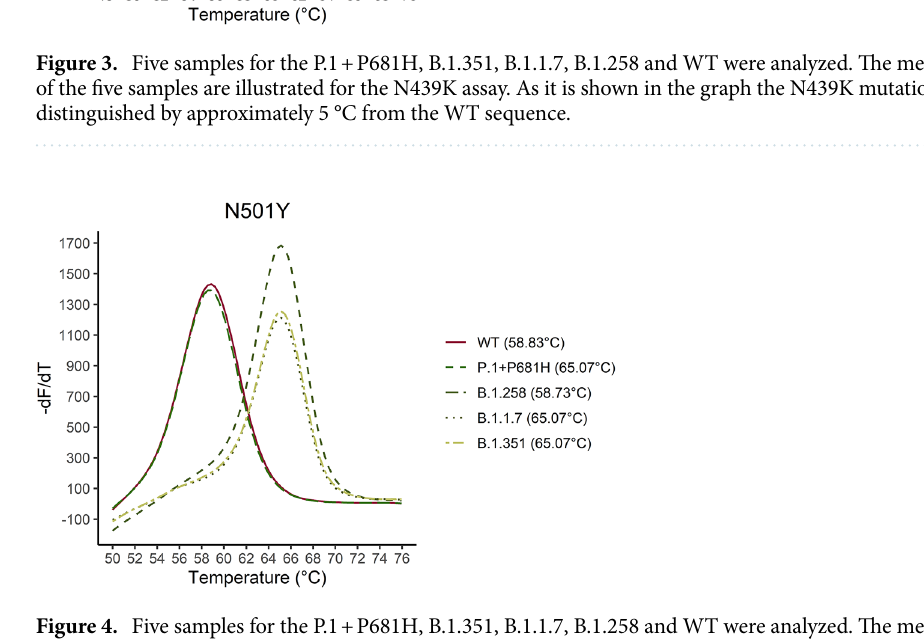
Figure 4. Five samples for the P.1 + P681H, B.1.351, B.1.1.7, B.1.258 and WT were analyzed. The melting curve of the five samples are illustrated for the N501Y assay. As it is shown in the graph the N501Y mutation can be distinguished by approximately 6 °C from the WT